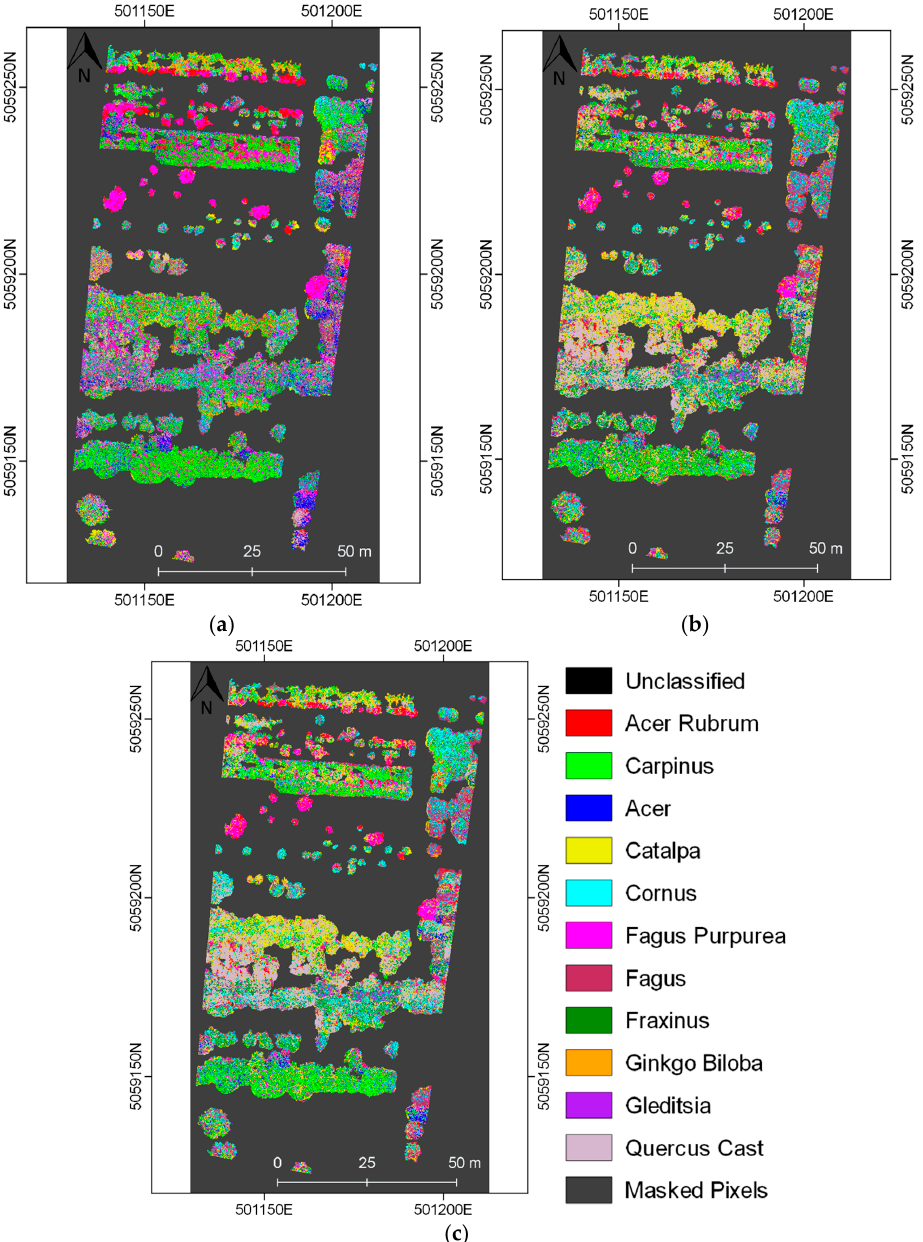
Figure 12. Classification results for the first layer stack ( a ), the third layer stack ( b ) and the sixth layer stack ( c ).